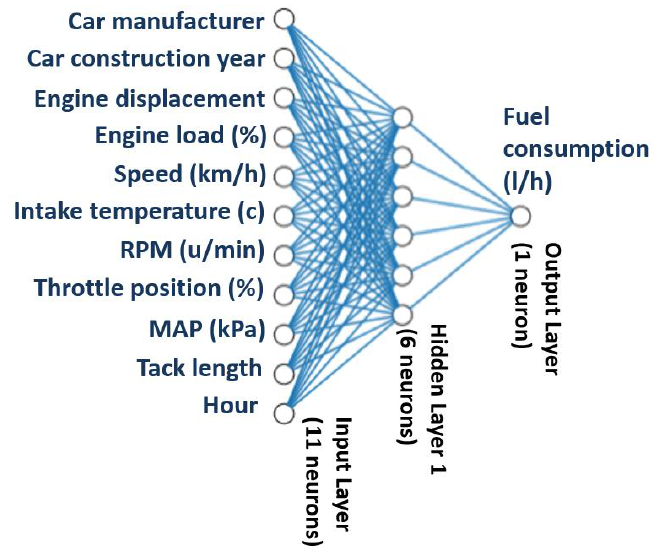
Figure 4. Representation of the ANN model developed. The ‘relu’ neuron activation function was used in all the hidden and output layers. ‘Adam’ was used as the optimization algorithm, with ‘normal’ for the NN weight